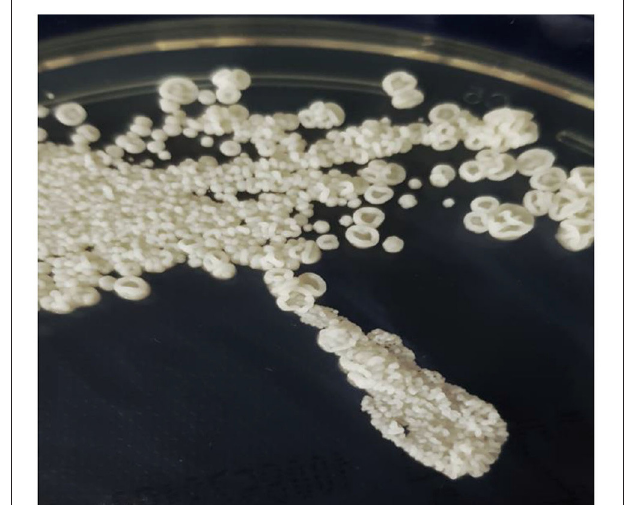
FIGURE 2 | Trichosporon japonicum colony morphology, grown on Sabouraud-gentamicin-chloramphenicol-2-agar (SGC2) at 30 ◦ C for 4 days